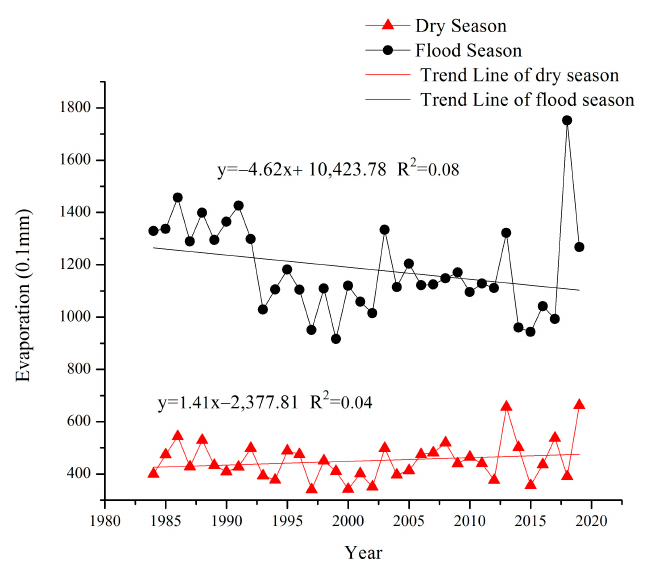
Figure 8. Sum of the seasonal evaporation in Poyang Lake during 1977–2020.